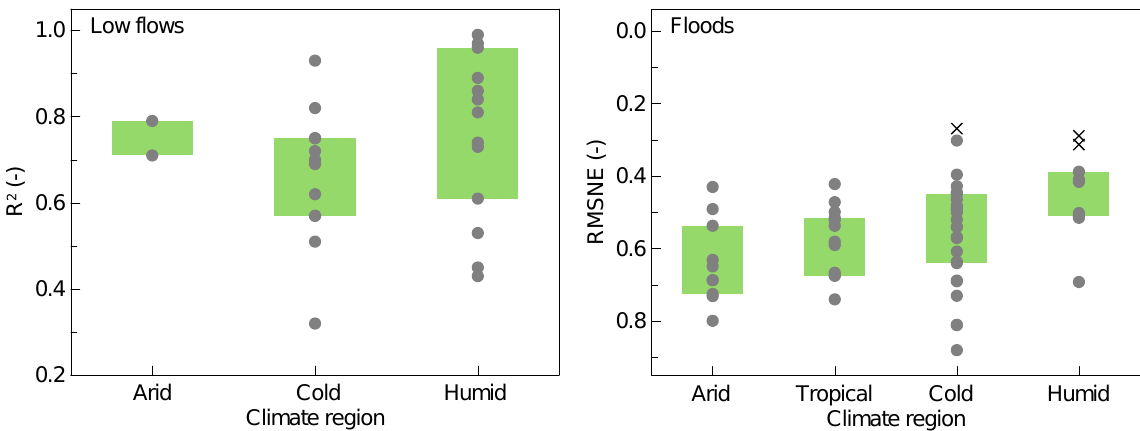
Fig. 2. Coefficient of determination of predicting low flows in ungauged basins (left) and root mean squared normalised error of predicting floods in ungauged basins (right), stratified by climate (Level 1 assessment). Each symbol refers to a result from the studies in Tables 1 and 3. Circles represent performances calculated on specific discharges (m 3 s − 1 km − 2 ) , crosses represent performances calculated on discharges (m 3 s − 1 ) . Boxes show 25–75%